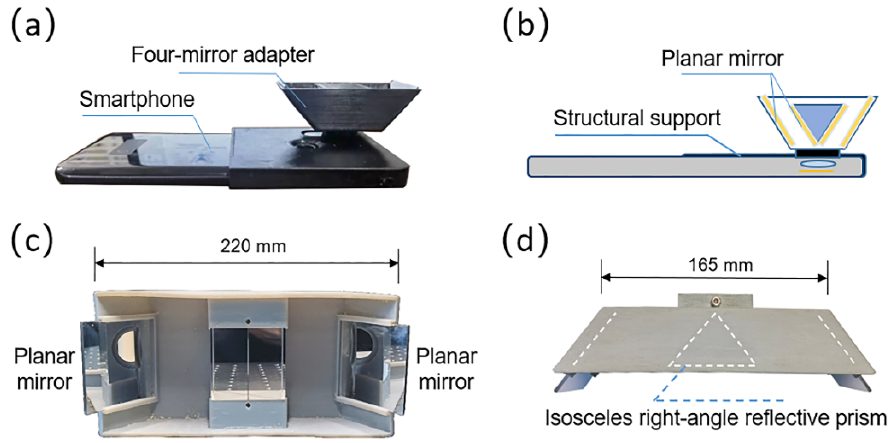
Figure 2. ( a ) The smartphone attached with a four-mirror adapter used in this work. ( b ) Cutaway view of the smartphone-based stereovision system. ( c , d ) are photographs of the front and top view of the four-mirror adapter in the industrial-camera-based stereovision system.